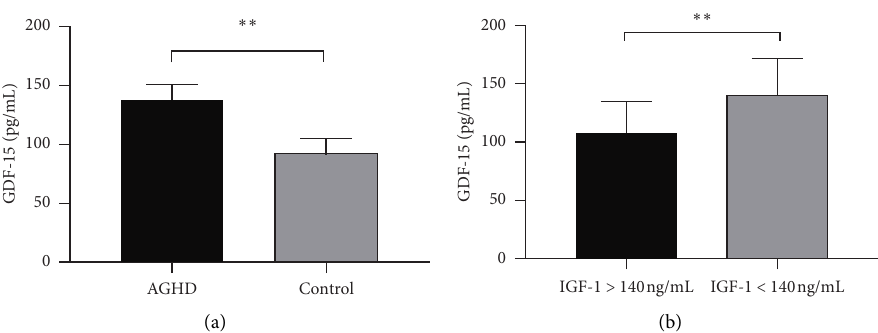
Figure 1: The serum levels of GDF-15. (a) Serum GDF-15 levels of AGHD increased; (b) serum GDF-15 levels increased significantly in the subgroup with IGF-1 < 140ng/mL of AGHD patients ( ∗∗ P < 0 . 01 ) .